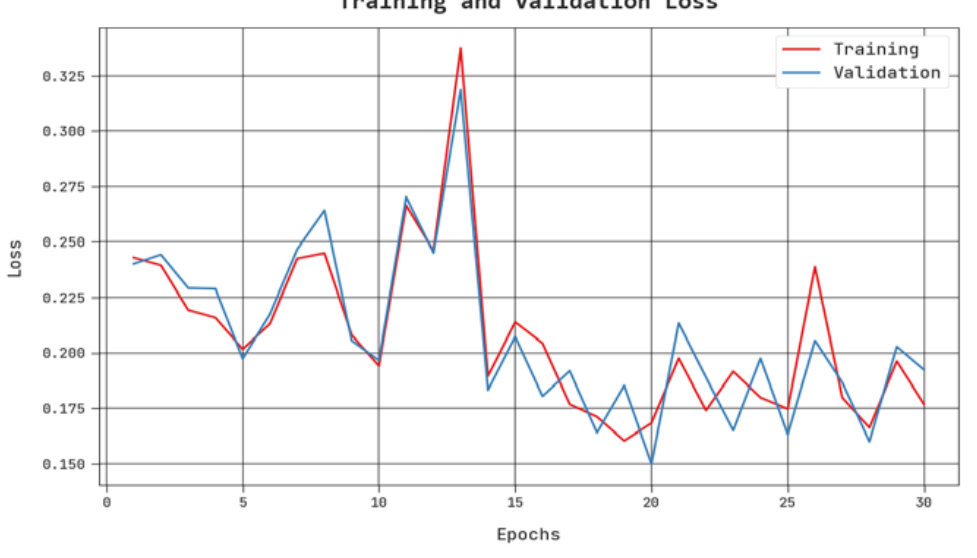
Figure 9. TLS and VLS analysis of the PPIE-ODLASC approach. A clear precision-recall investigation of the PPIE-ODLASC approach under test superior values of precision-recall values under several classes.